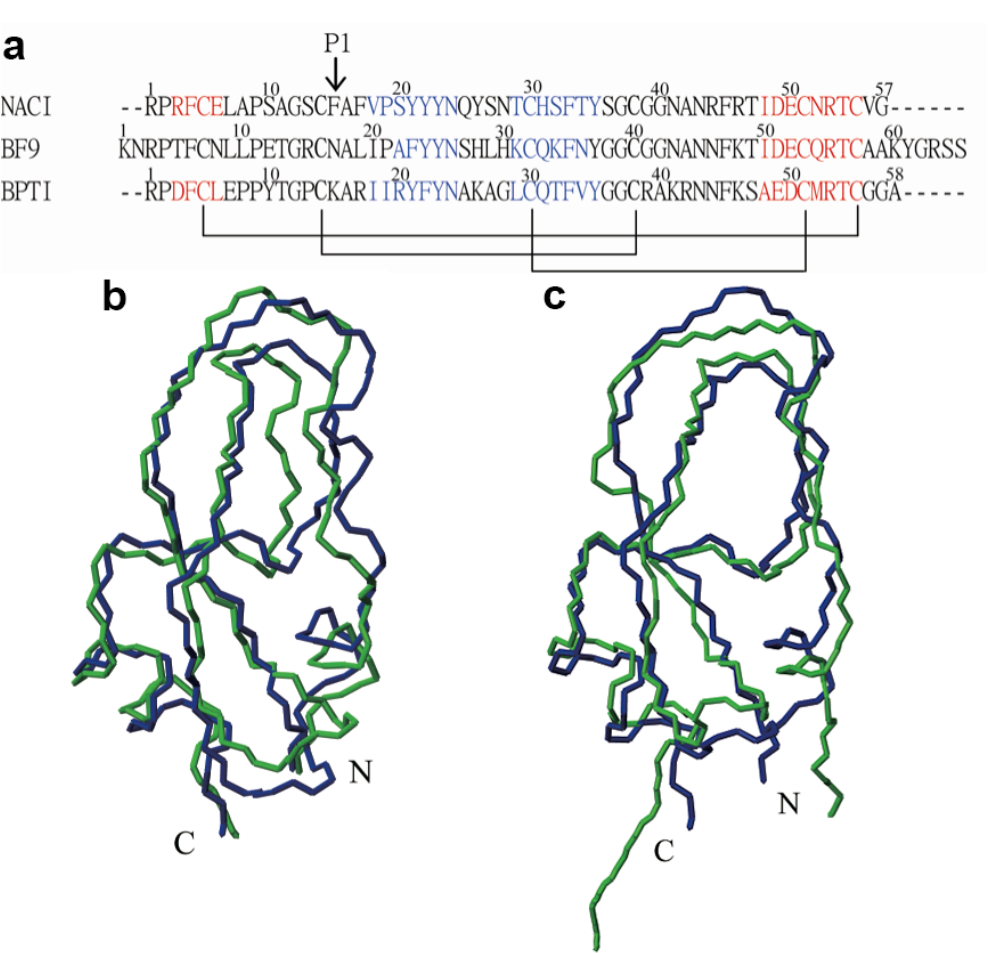
Figure 3. Sequence and structure comparison of NACI with homologues. ( a ) Sequence alignment of NACI with BF9 and BPTI. The secondary structure elements for NACI, BF9, and BPTI are shown in blue ( β -strands) and red (helices). Disulfide bonds are shown with black lines. The arrow indicates the P1 residue. ( b ) Structural comparison between the mean structures of NACI (blue) and the BPTI (green). ( c ) Structural comparison between the mean structures of NACI (blue) and the BF9